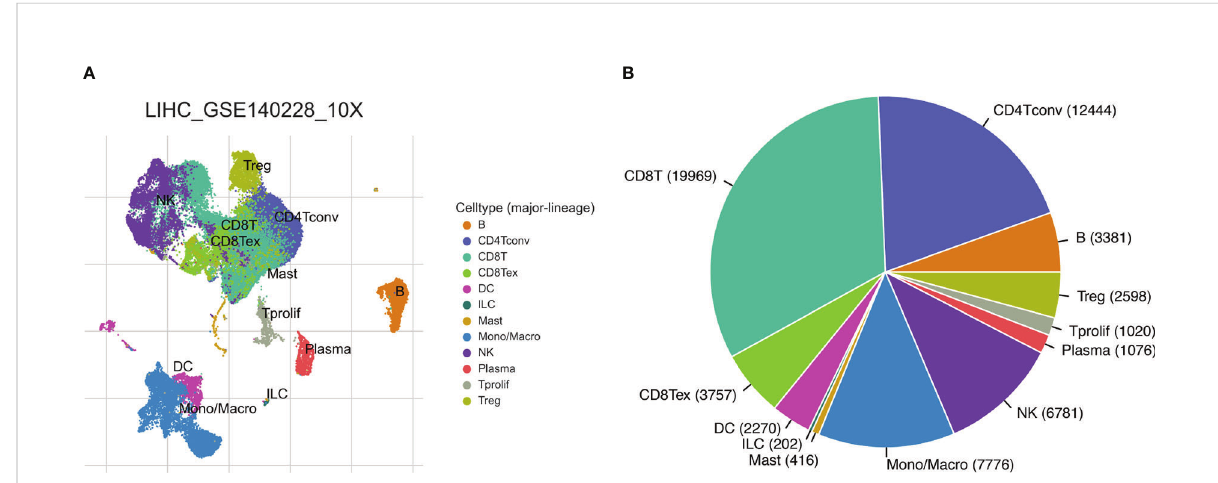
FIGURE 1 HCC single-cell sequencing data from the droplet-based platform. (A) The UMAP plot of different cell types. (B) Ratios of different cell